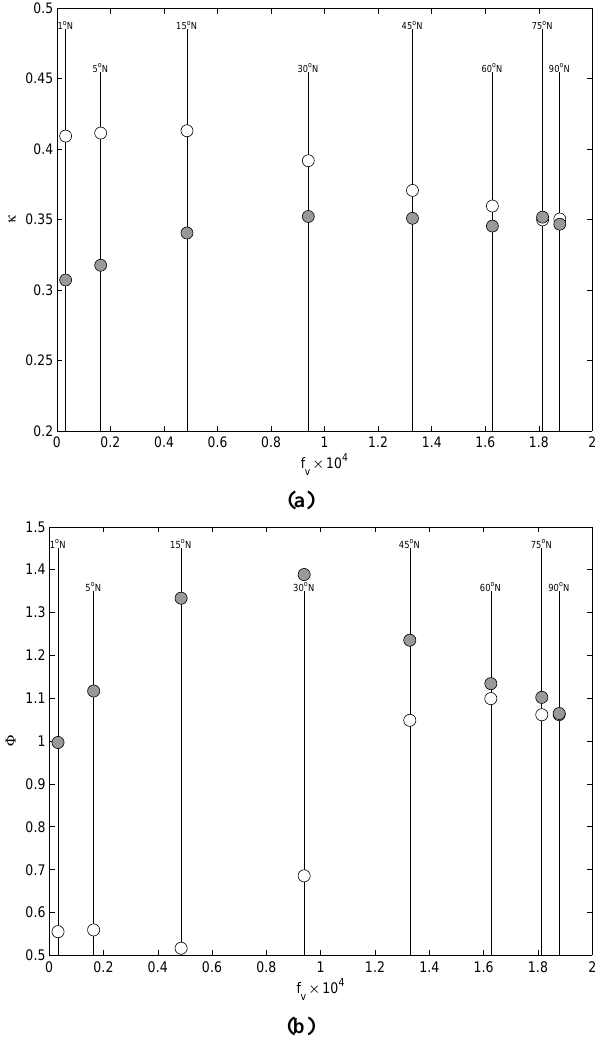
Fig. 6. The non-dimensional velocity profile: (a) the von Karman constant k in LES averaged over the lowest 15% of the EBL; (b) 8 computed with this k and averaged over the same fraction of the EBL. Shaded circles show the WE-EBL; open circles, the EW-EBL. The data correspond to hour six of integration.